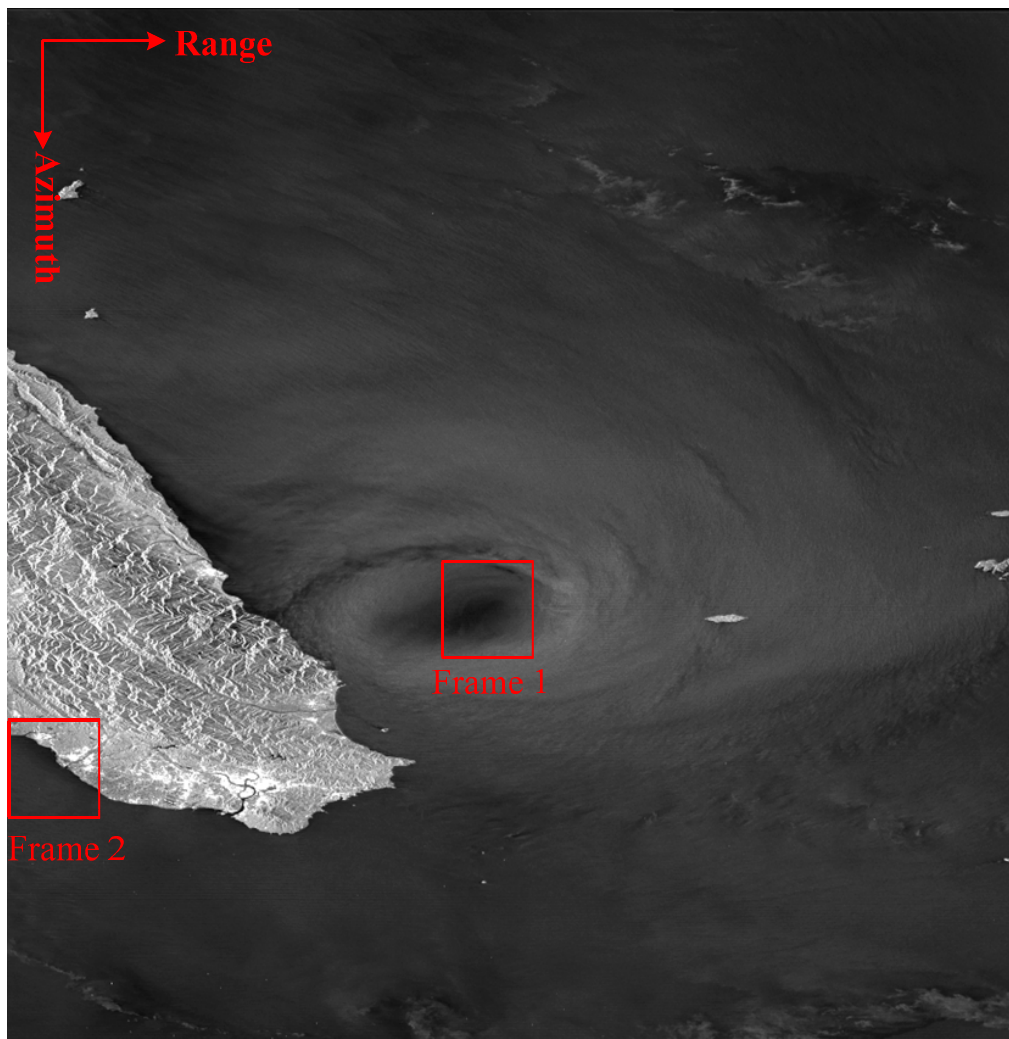
Figure 15. Descalloping result of ocean image: Scene ID: 3935909; Imaging Mode: NSC; Polar Mode: HH; Date: 2017-07-29; Area: Taiwan, China.